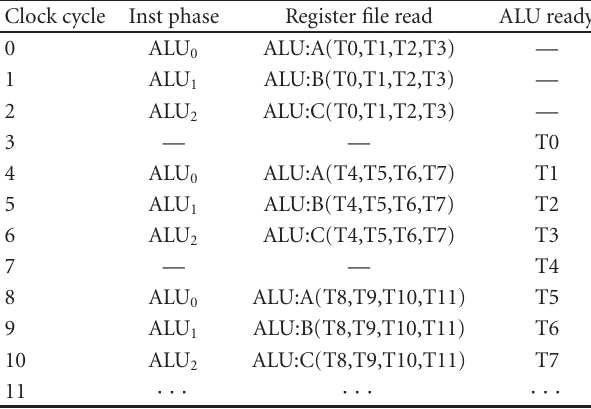
Table 1: The schedule of operand reads from the central register file for batches of four threads (T0–T3, T4–T7, etc.) decoding only ALU instructions. An ALU instruction has up to three vector operands (A, B, C) which are read across threads in a batch over three cycles. In the steady state this schedule can sustain the issue of one ALU instruction from every